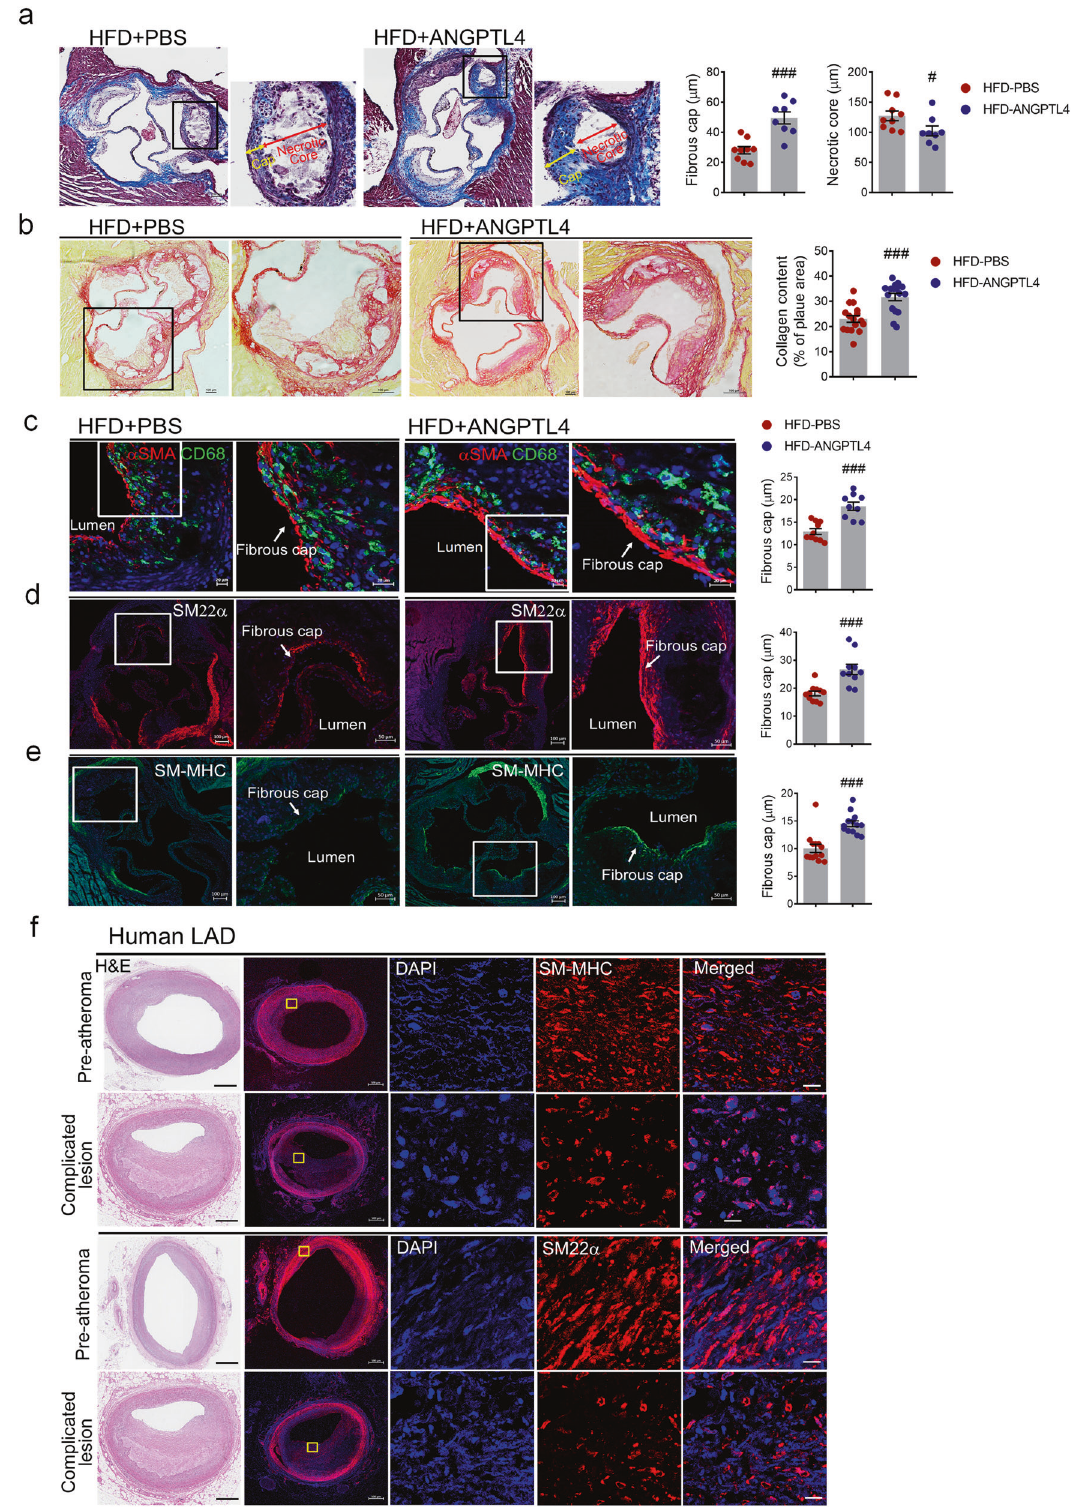
Fig. 4 Effects of ANGPTL4 on the stability of atherosclerotic plaques. a – e Representative histologic analysis of the aortic root from the PBS and ANGPTL4 groups. a Representative images of Masson trichrome staining are shown. Boxed areas in the aortic root depict the fi brous cap and necrotic core at higher magni fi cation, and the fi brous cap and necrotic core were measured as the lesion thickness. Scale bar, 100 μ m. b Representative images of picrosirius red staining for collagen, and quanti fi cation of the collagen content presented as a percentage of the plaque area. Scale bar, 100 μ m. Immuno fl uorescence staining of atherosclerotic plaques showed α -SMA and CD68 ( c ), SM22 α ( d ), and SM-MHC ( e ) in the fi brous caps. Quanti fi cation of the fi brous cap thickness is presented in the right panels. Scale bar, 20 μ m. f H&E (left panels) and SM- MHC and SM22 α -stained confocal images of lesions representing preatheromatous plaques and complicated lesions of the human LAD. Scale bar, 10 μ m. Data were presented as the mean ± SEM. # p < 0.05, ### p < 0.001 (by Student ’ s t- test). LAD left anterior descending